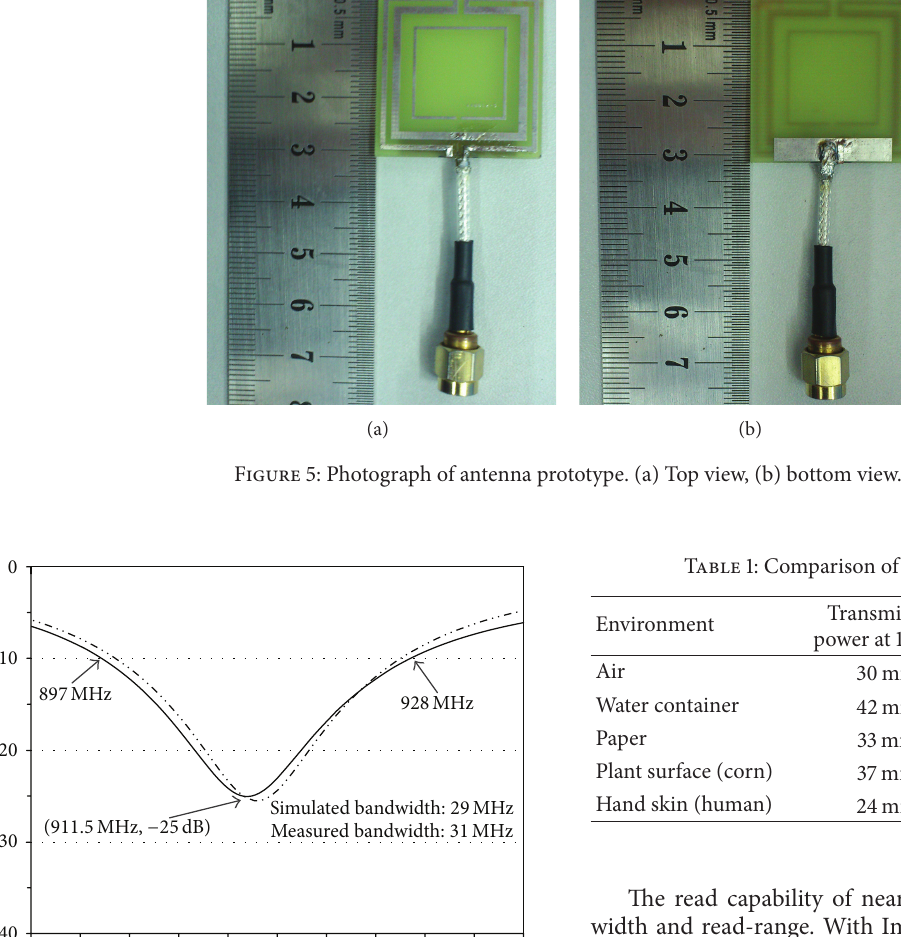
Figure 6: Reflection coefficient for proposed antenna.